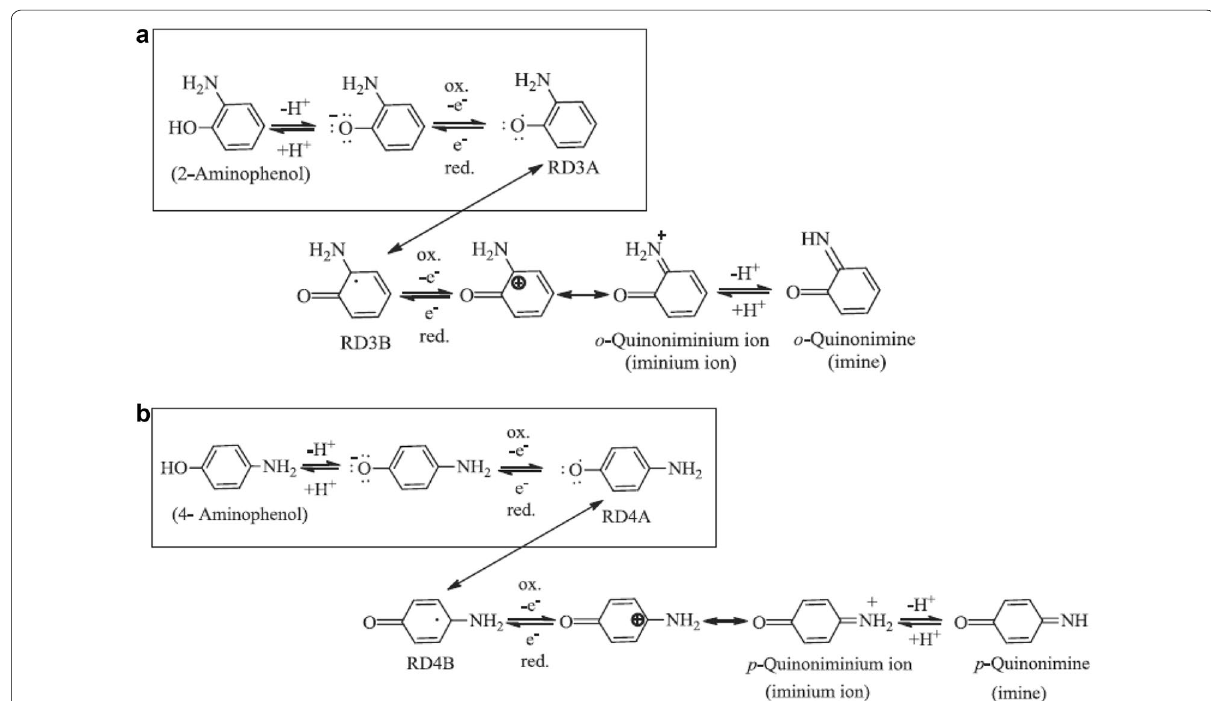
Fig. 4 a Proposed electron transfer pathways of interconversion between 2AP and o ‑quinonimine, b Proposed electron transfer pathways of inter‑ conversion between 4AP and p ‑quinonimine [Ref. Fig. 3 in Chen et al.